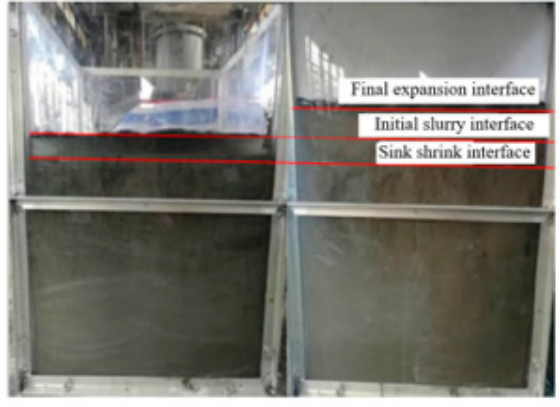
Figure 11. The pores in backfilling body.